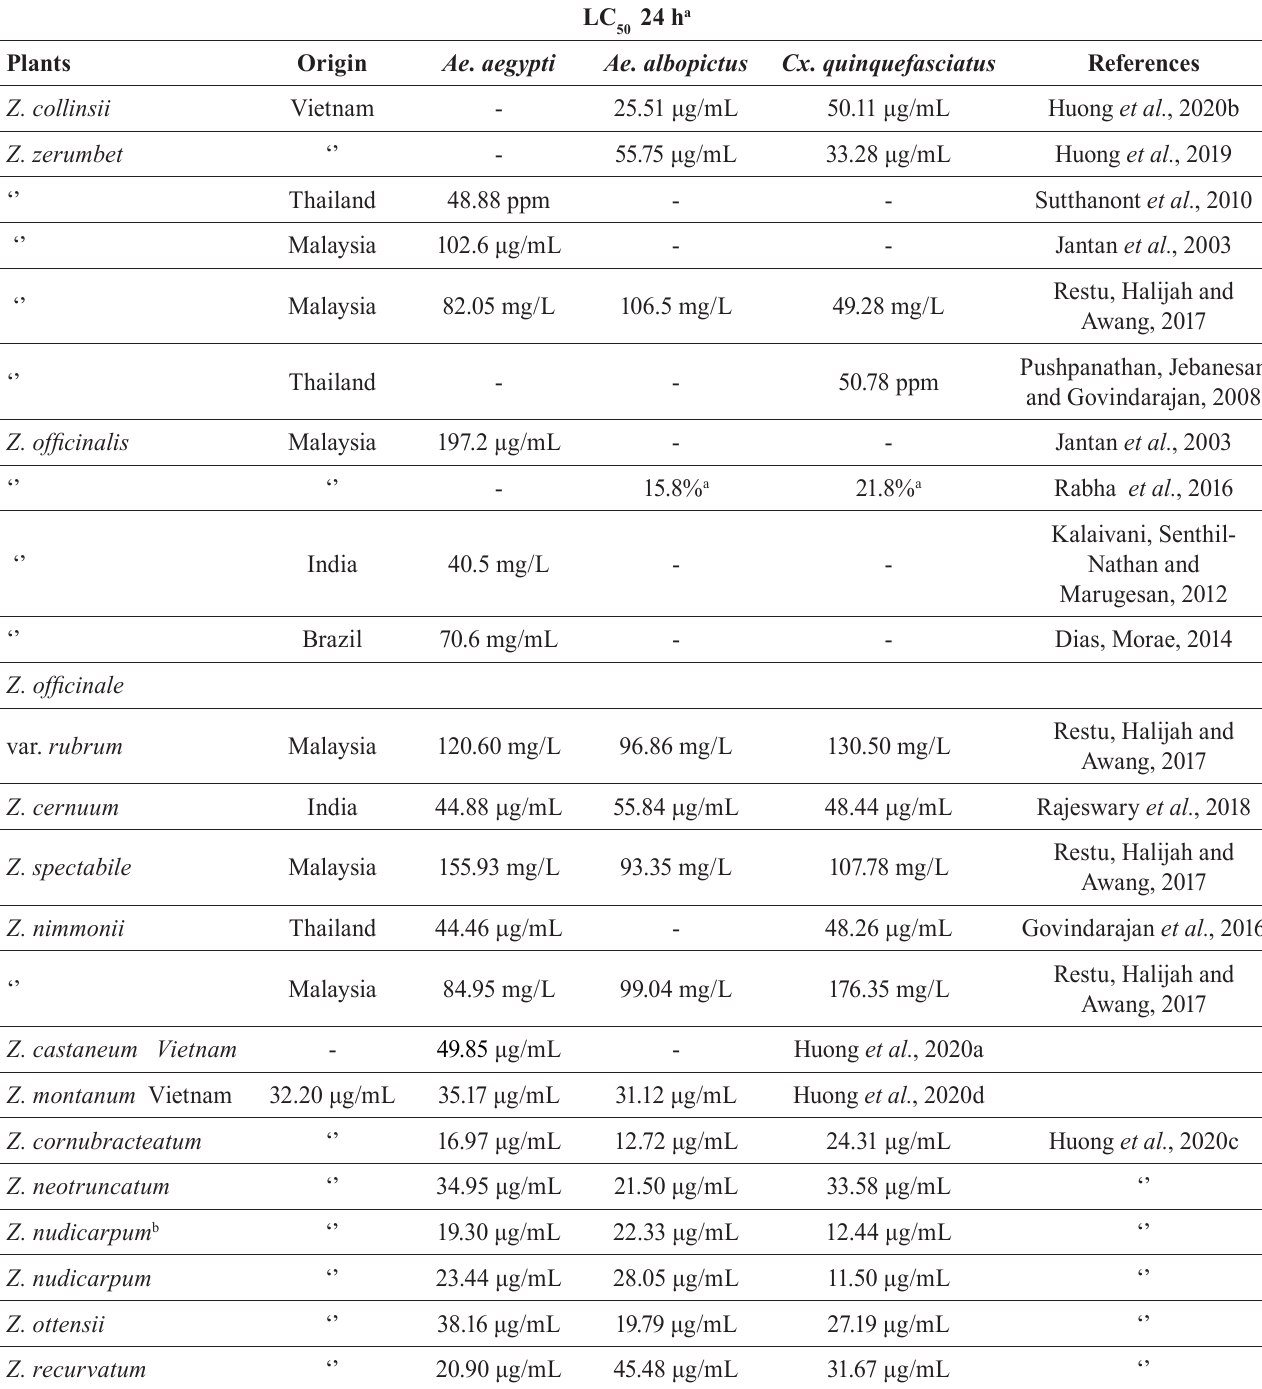
TABLE IV - Larvicidal activity of essential oils of some Zingiber